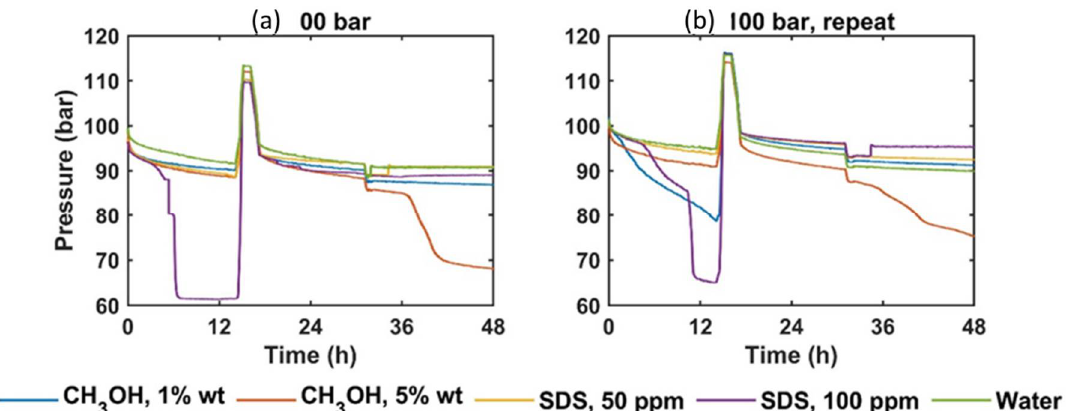
Figure 7. Pressure variation during temperature reduction from 1 °C to −4 °C during the isothermal experiment. Temperature reduces to −4 °C after 30 h. ( a , b ) show the pressure variation during the first and second trial. The pressure increase above initial pressure is on account of temperature increased from 1 °C to 25 °C. (Starting pressure is pressure at 1 °C).